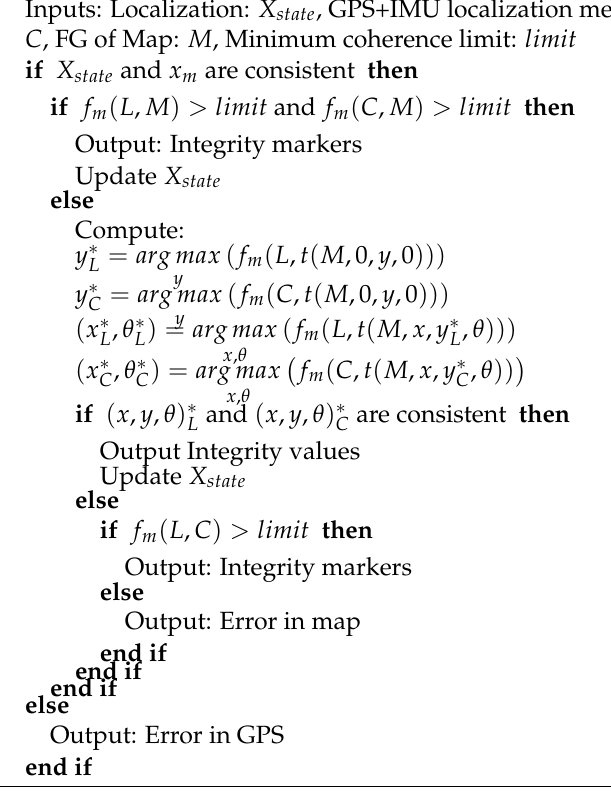
Algorithm 1 Algorithm for localization